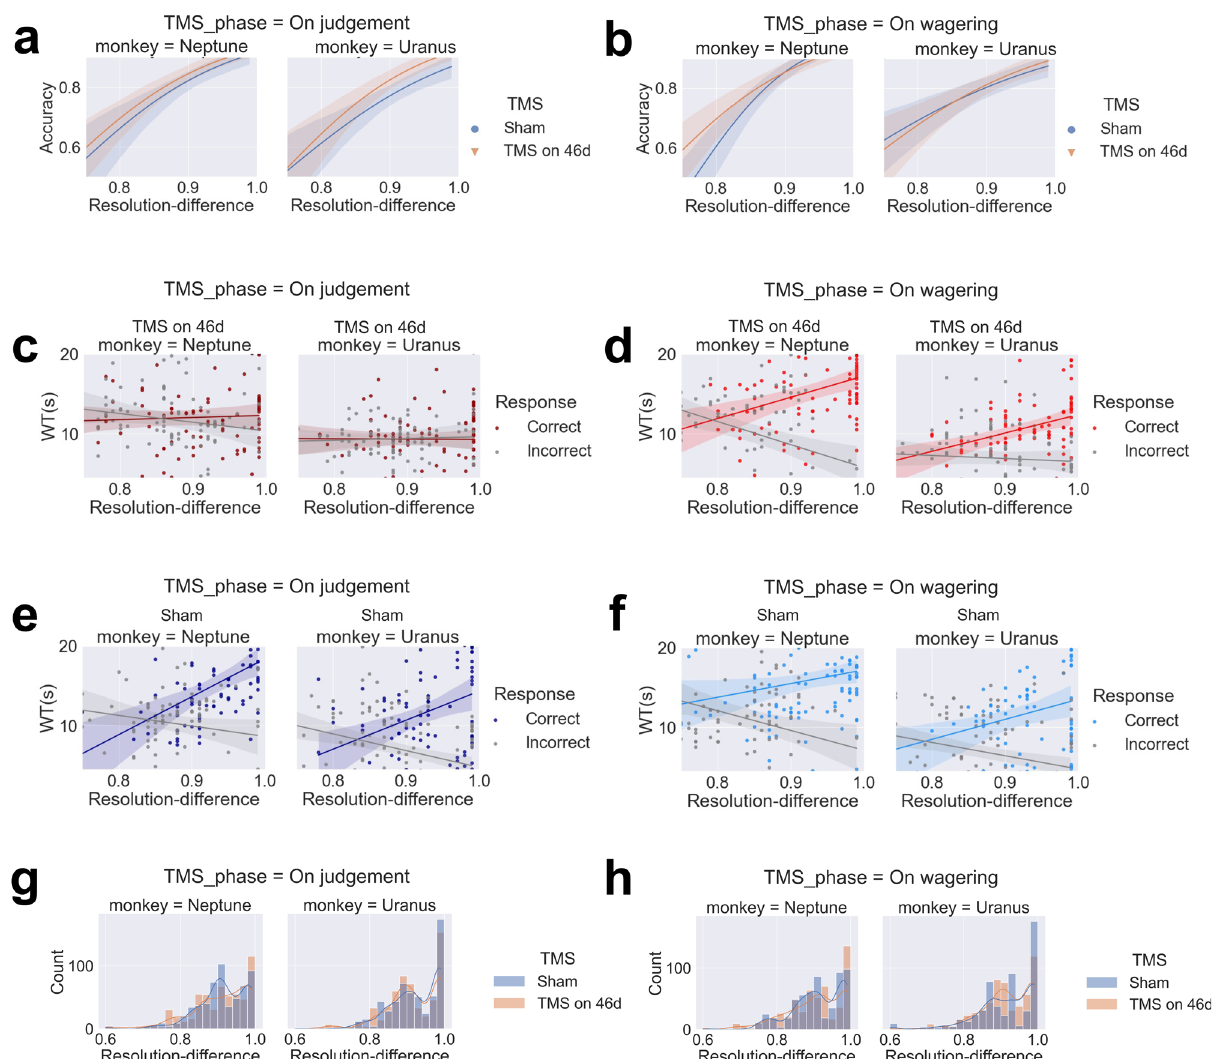
Fig. 4 On-judgement TMS distorts the trial-dif fi culty psychometric curve. Accuracy decreases with task dif fi culty (resolution difference; higher values indicate lower task dif fi culty). The lines are logistic regression fi ts for accuracy with resolution difference as a factor, calculated separately for the TMS- sham and TMS-46d conditions in the on-judgement phase ( a ) and on-wagering phase ( b ). WT decreased with task dif fi culty in correct trials and increased with task dif fi culty in incorrect trials in all control conditions ( d , f ), but this pattern was absent in the on-judgement phase of the TMS-46d condition ( c ). Distributional differences between TMS-46d and TMS-sham conditions were not signi fi cant in either on-judgement phase ( g ) or on-wagering phase ( h ), indicating task dif fi culty were well controlled. Resolution-difference bin size set to 0.02; colored lines indicate kernel density estimation. Shaded areas indicate bootstrap-estimated 95% con fi dence intervals for the regression